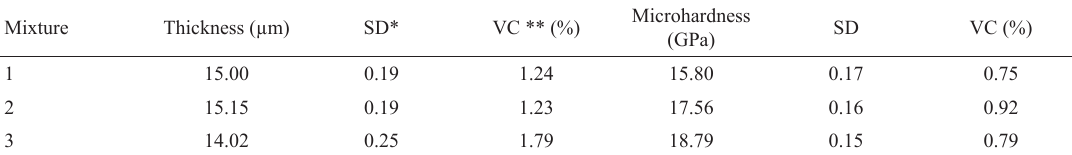
Table 3: Coating thickness and maximum microhardness value in the cross section of the carbide layers.